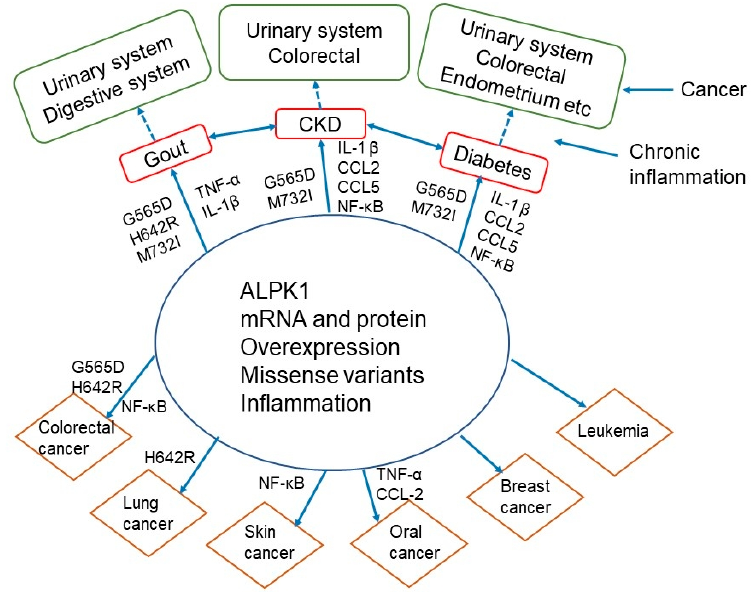
Figure 3. ALPK1 is associated with cancer, gout, chronic kidney disease and diabetes. ALPK1 variants and inflammatory markers were not detected in all studies. However, they have common missense variants (such as G565D), higher mRNA and protein expression of ALPK1, and also share inflammatory mechanisms. These diseases are considered to be cancer-related inflammatory diseases. Currently, no studies have examined the role of ALPK1 in the carcinogenesis of gout, chronic kidney disease and